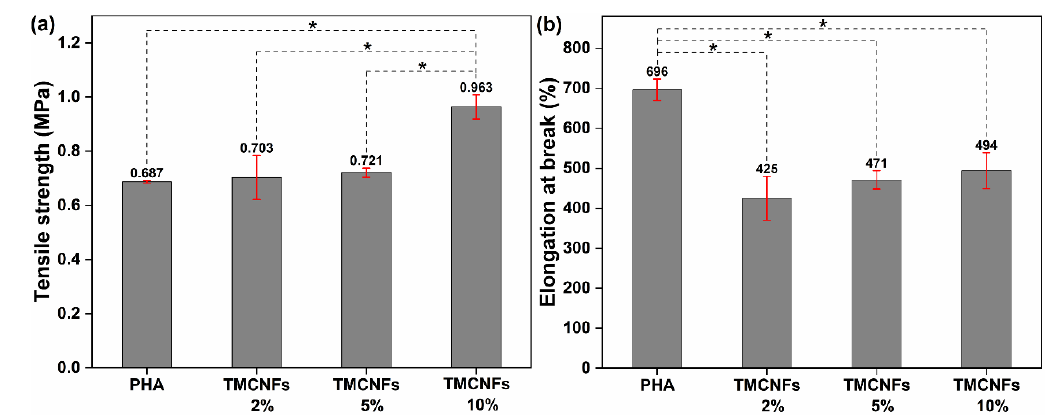
Figure 8. Mechanical properties of the PHA–TMCNFs composites, ( a ) Tensile strength; ( b ) Elongation at break (*: significance level <0.05).